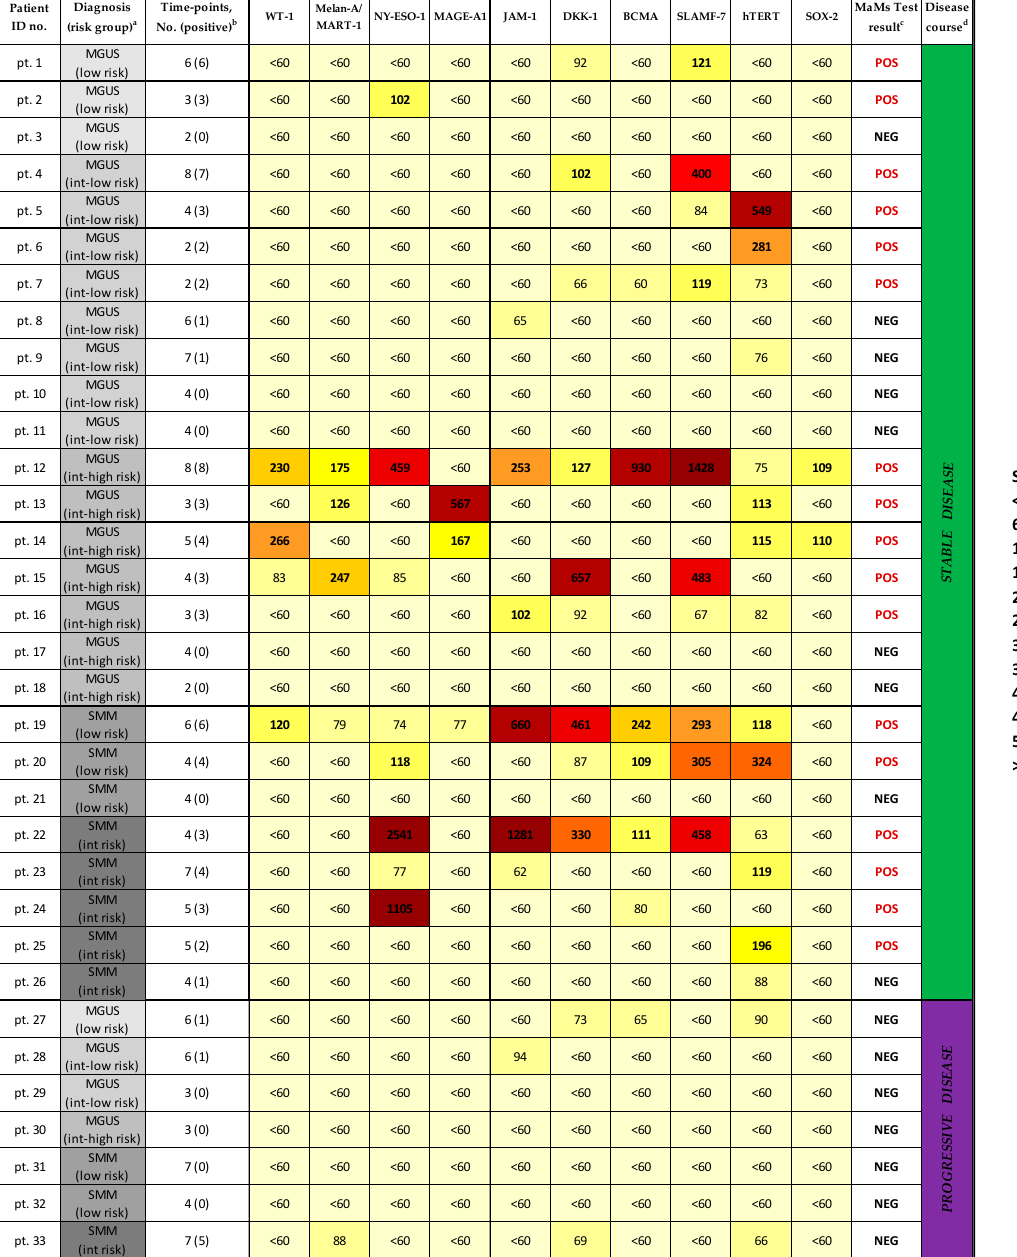
Figure 1. Heatmap-based report of Multi-antigenic Myeloma-specific (MaMs) T-cell monitoring in 33 MGUS/SMM patients, with either stable or progressive disease. For each patient, mean positive values (SFCs) are reported for each MM-associated antigen (MMAA) tested (values >100 SFCs are highlighted in bold). a Diagnosis and risk category (according to Mayo Clinic models) are indicated for each patient, at the time of enrollment. b Total number of follow-up samples (time-points) analyzed and number of time-points with detectable (positive) responses, according to the detection limit of the ELISpot assay (>60 SFCs), are indicated for each patient. c Overall assessment by MaMs test (either positive or negative result, according to the threshold of 100 SFCs, in ≥ 1 MMAA) is shown for each patient. d All patients were classified as showing either stable or progressive disease (according to the definitions reported in Section 2.1, in order to evaluate the correlation between the MaMs test result and the clinical course.